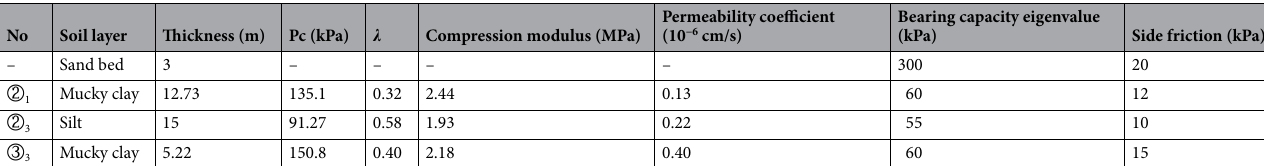
Table 2. Physico-mechanical properties of caisson soil.